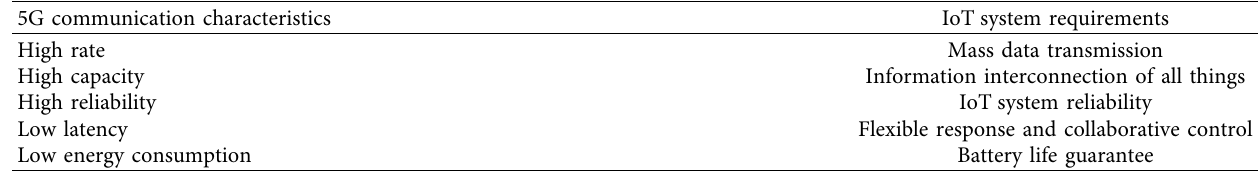
Table 1: Correspondence between 5G communication characteristics and IoT system